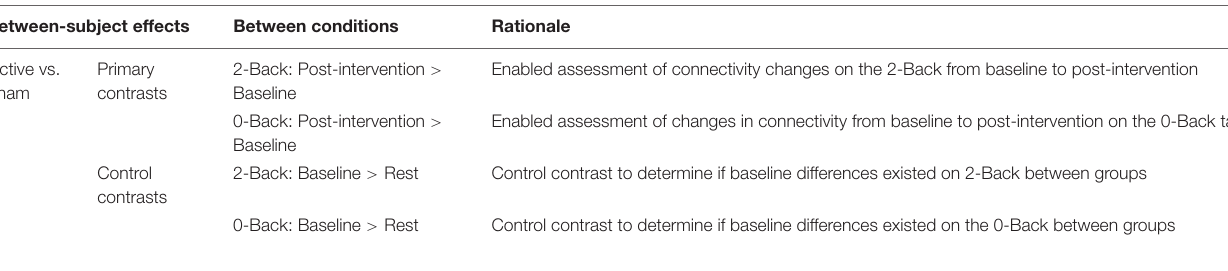
TABLE 3 | Description and rationale of second level